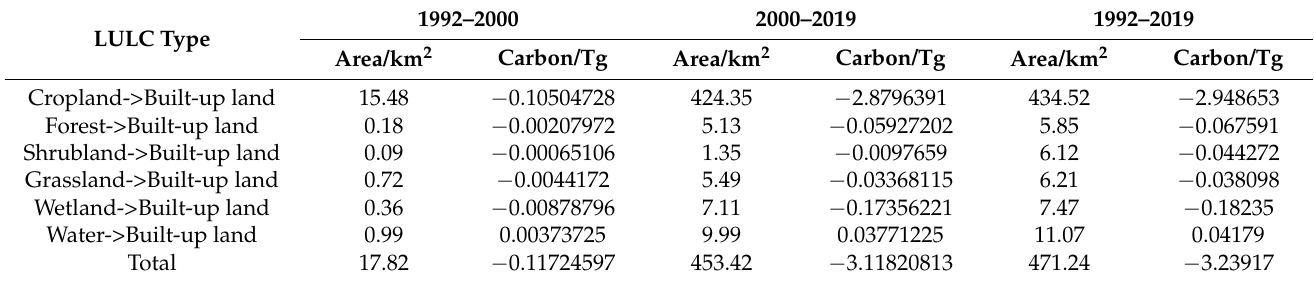
Table 6. Changes in carbon storage from the transition of other land types to built-up